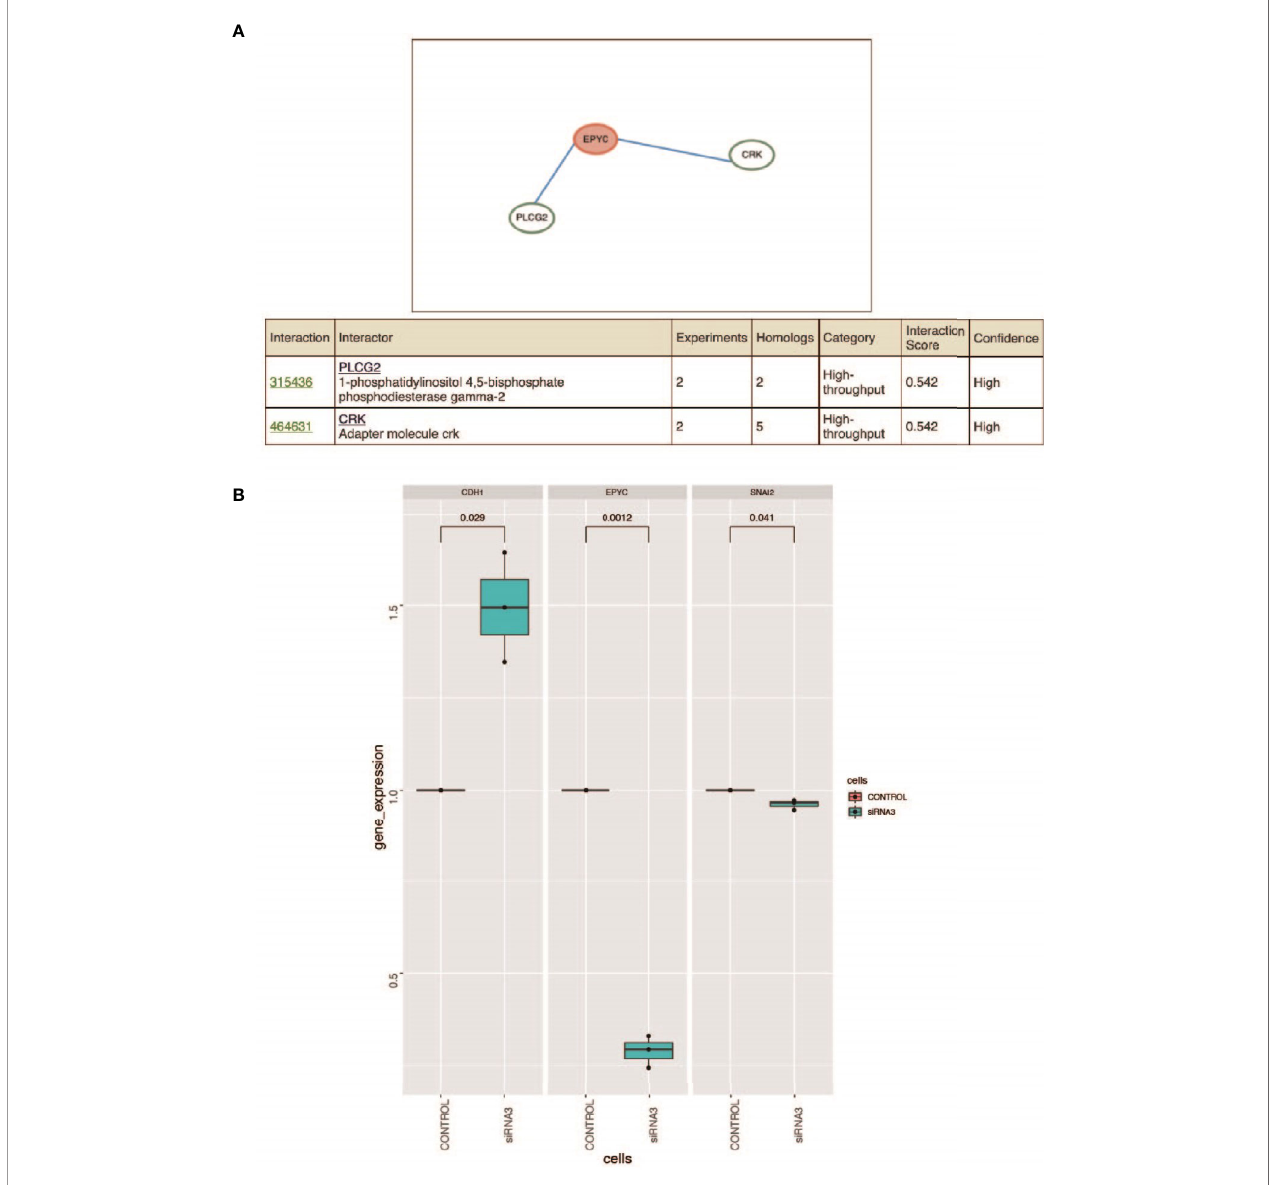
FIGURE 5 | (A) Prediction of the interacted proteins of EPYC on HitPredict website. (B) After siRNA interferes with the expression of EPYC, the expression of SNAI2 is down-regulated and the expression of CDH1 is up-regulated. Changes in the expression of SNAI2 and CDH1 after the down-regulation of EPYC expression. Using qRT-PCR, it was found that after siRNA interfered with EPYC expression, SNAI2 expression was down-regulated, while CDH1 expression was signi fi cantly